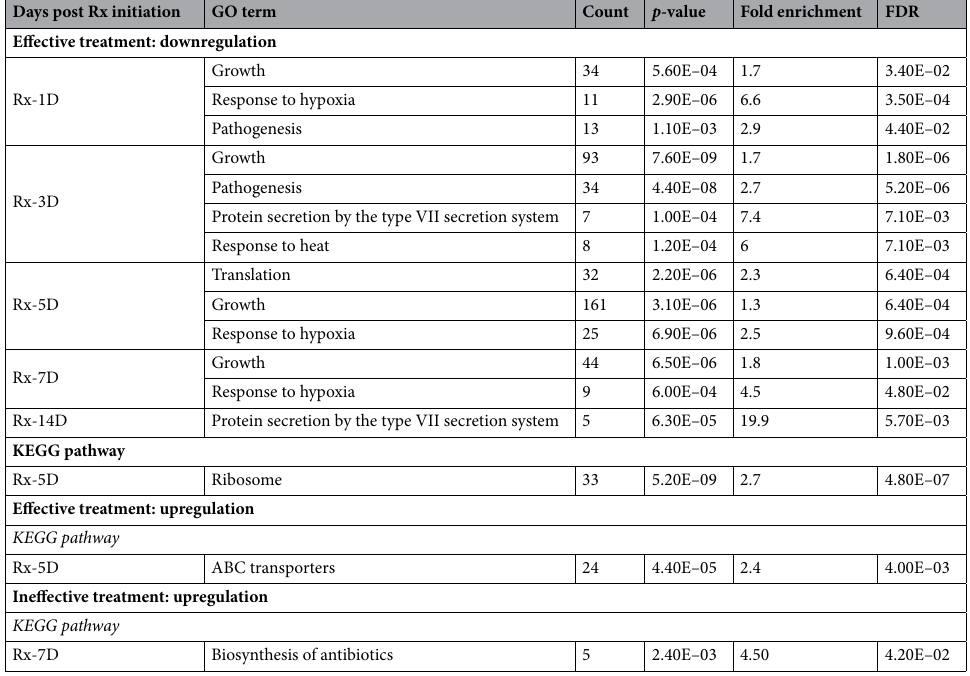
Table 2. Enrichment analysis for biological process and KEGG pathways. Enrichment of genes in biological process and KEGG 26 pathway was performed using the functional annotation tool of the Database for Annotation, Visualization, and Integrated Discovery (DAVID) web interface v 6.8 27 . Rx- Treatment, Rx-1D to Rx-14D – days post-treatment initiation, p -Value < 0.05 considered significant, FDR false discovery